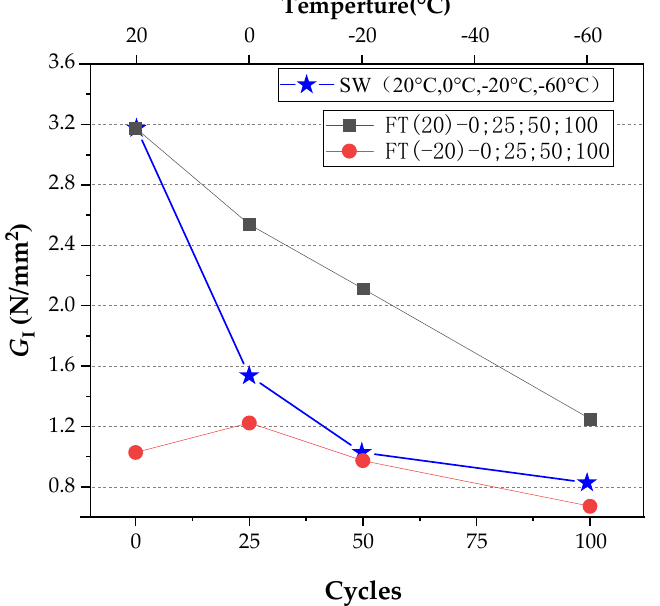
Figure 18. Comparison of G I of SW series at four target temperatures and G I of test group after different freeze–thaw cycles at 20 and − 20 °C.